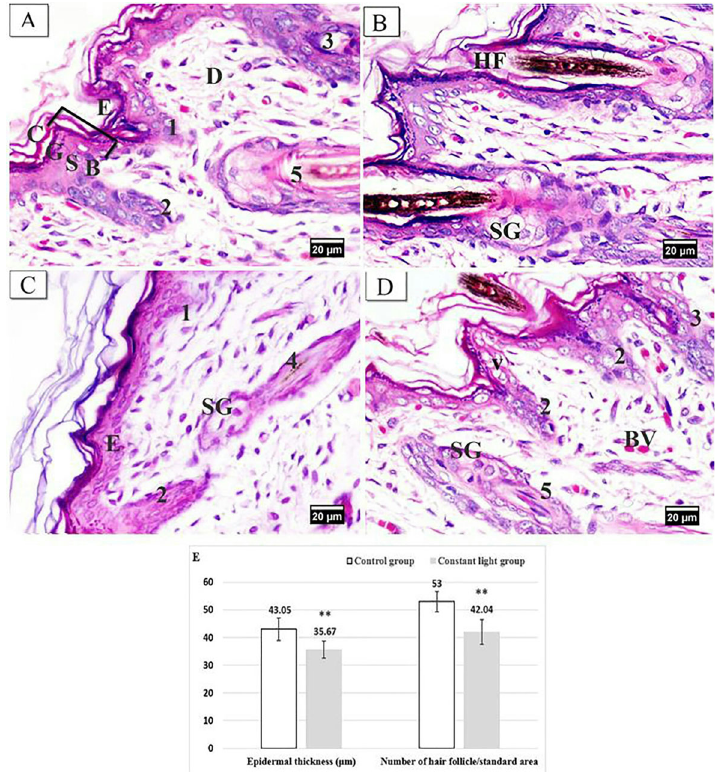
Figure 2. Photomicrographs of H&E-stained sections of dorsal skin of neonate rabbits ( (cid:1) 400, scale bar 20 m m). A and B , Control group showing: A , epidermis (E), stratum corneum (C), stratum granulosum (G), stratum spinosum (S), stratum basale (B), dermis (D), and the different stages of hair follicle morphogenesis (stage 1, 2, 3, 5); B , terminal stage of the hair follicle (HF) and sebaceous gland (SG). C and D , Constant light group showing: C , markedly reduced epidermal thickening (E), early stages of hair follicles (1,2,4), and sebaceous gland (SG); D , keratinocytes shows vacuolated cytoplasm (V), congested dermal blood vessels (BV), and different stages of hair follicle morphogenesis (stage 2, 3, 5). E , Means ± SD of epidermal thickness and number of hair follicles per standard area. **P o 0.001 vs control group (unpaired